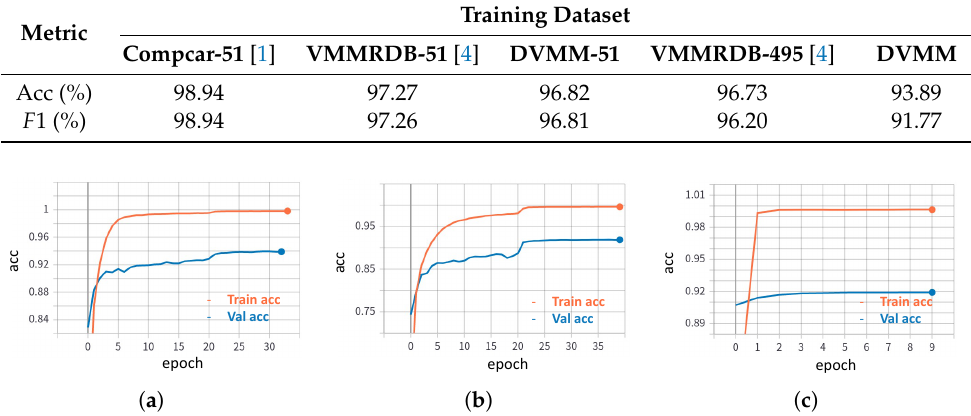
Figure 5. Accuracy plot during the training process of the proposed 2B–2S on the DVMM dataset. ( a ) Make recogniser (Stage 1). ( b ) Model recogniser (Stage 1). ( c ) The DM module (Stage 2).